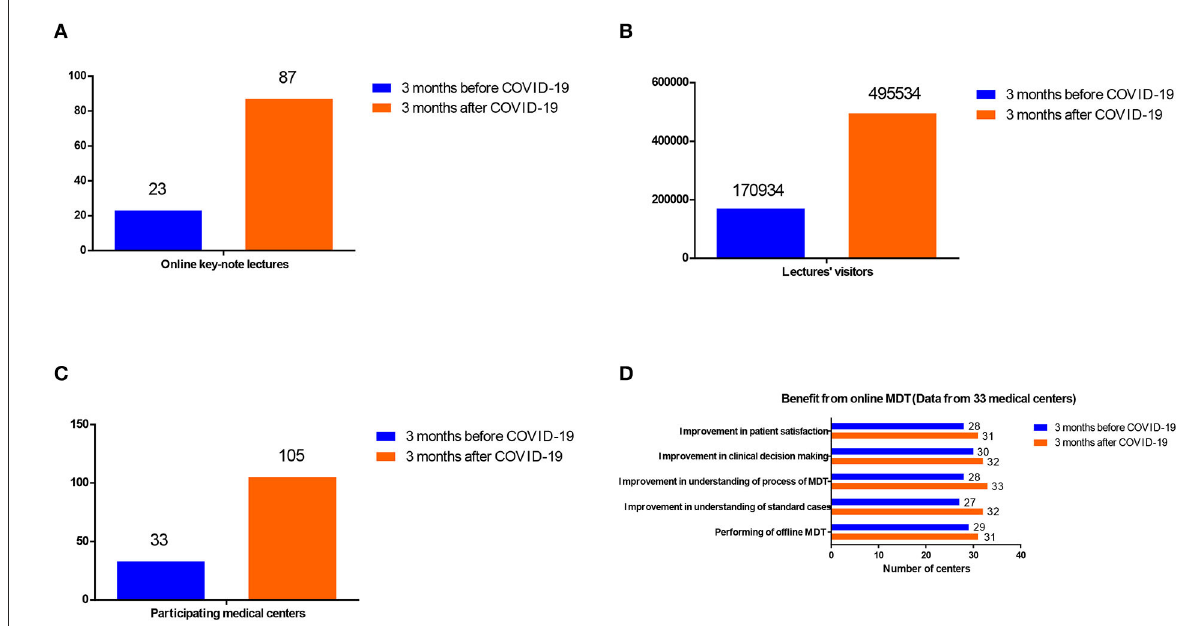
FIGURE4 Comparison of the education role of the online MDT platform in China before and after the outbreak of COVID-19 (A) the online key-note lectures, (B) the lecture visitors, (C) the participating medical centers, and (D) by the benefit from online MDT (Data from 33 medical centers).